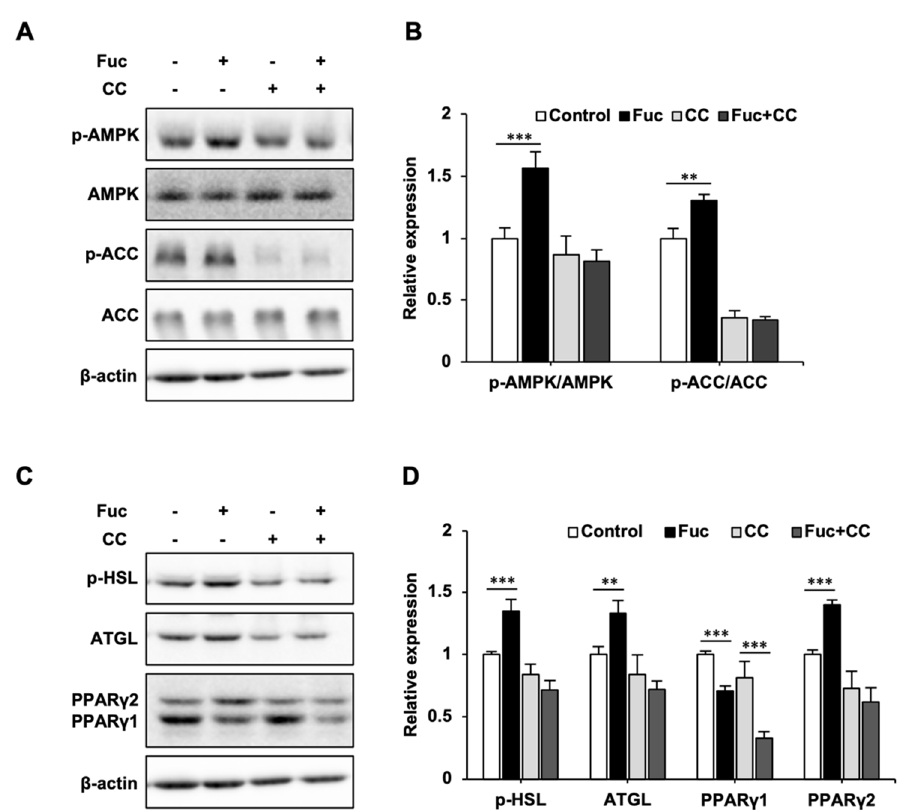
Figure 3. Effects of L-fucose (Fuc) and AMP-activated protein kinase (AMPK) inhibitor Compound C (CC) on lipid metabolism-related proteins. ( A , B ) Protein expression levels of p-AMPK, AMPK, p-acetyl-CoA carboxylase (ACC), and ACC in adipocytes cotreated with 10 µ M CC and Fuc for 24 h. ( C , D ) Protein expression levels of p-hormone-sensitive lipase (HSL), adipose triglyceride